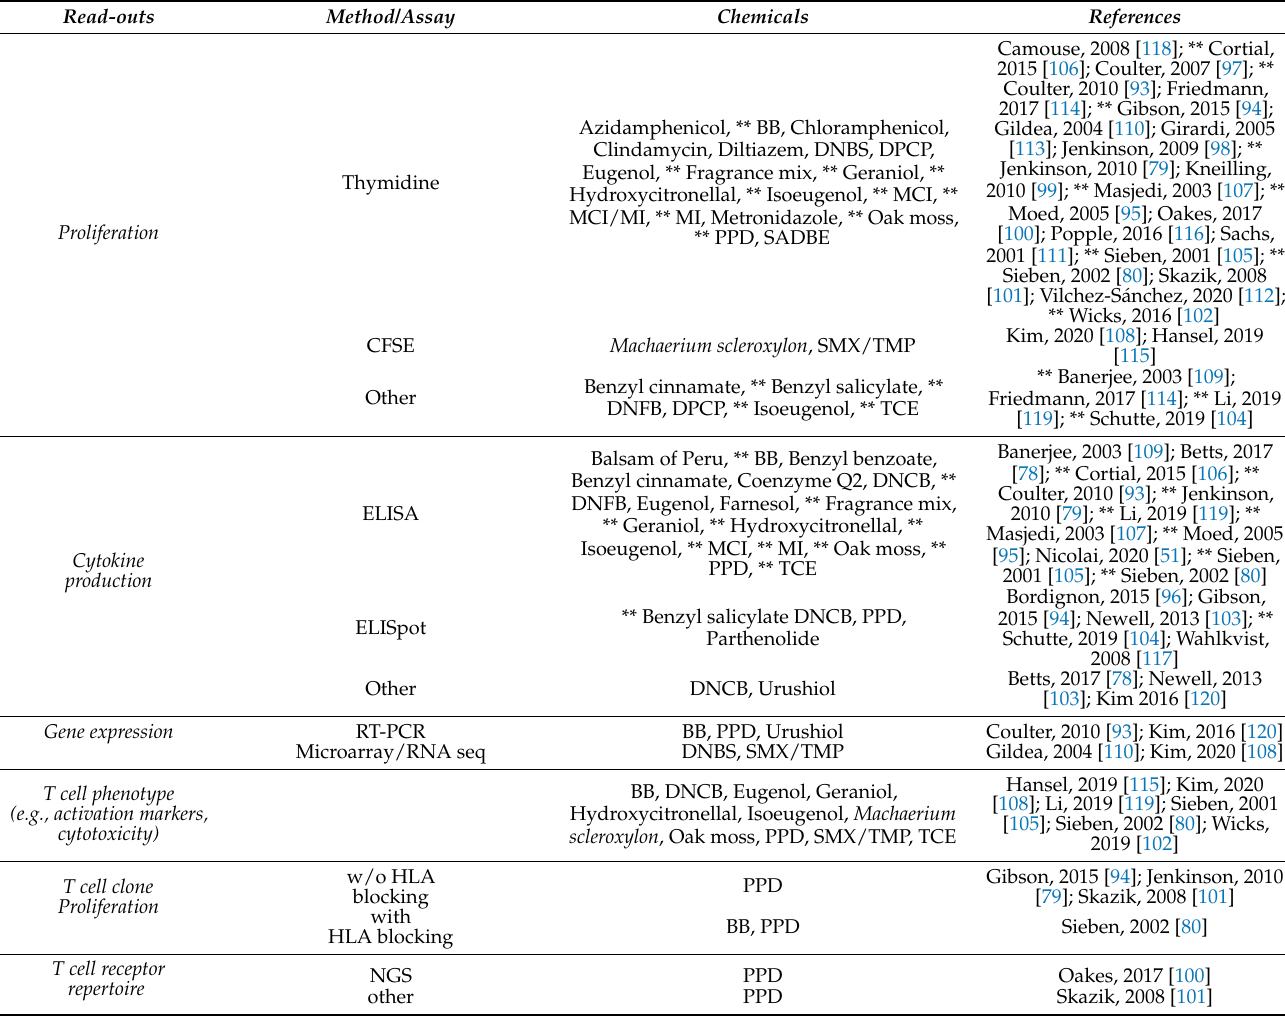
Table 3. T cell activation